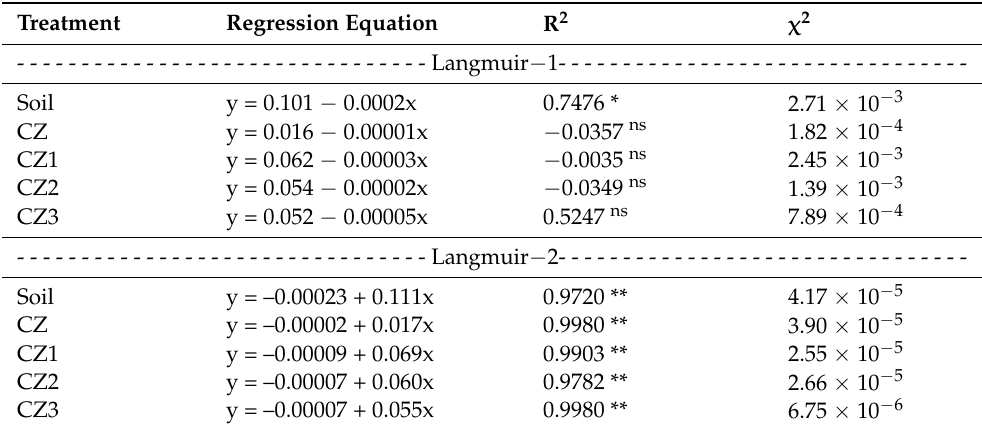
Table 12. Fitting Langmuir type 1, 2, and 3 isotherms to the nitrogen adsorption data based on simple regression and Chi-square analyses results.